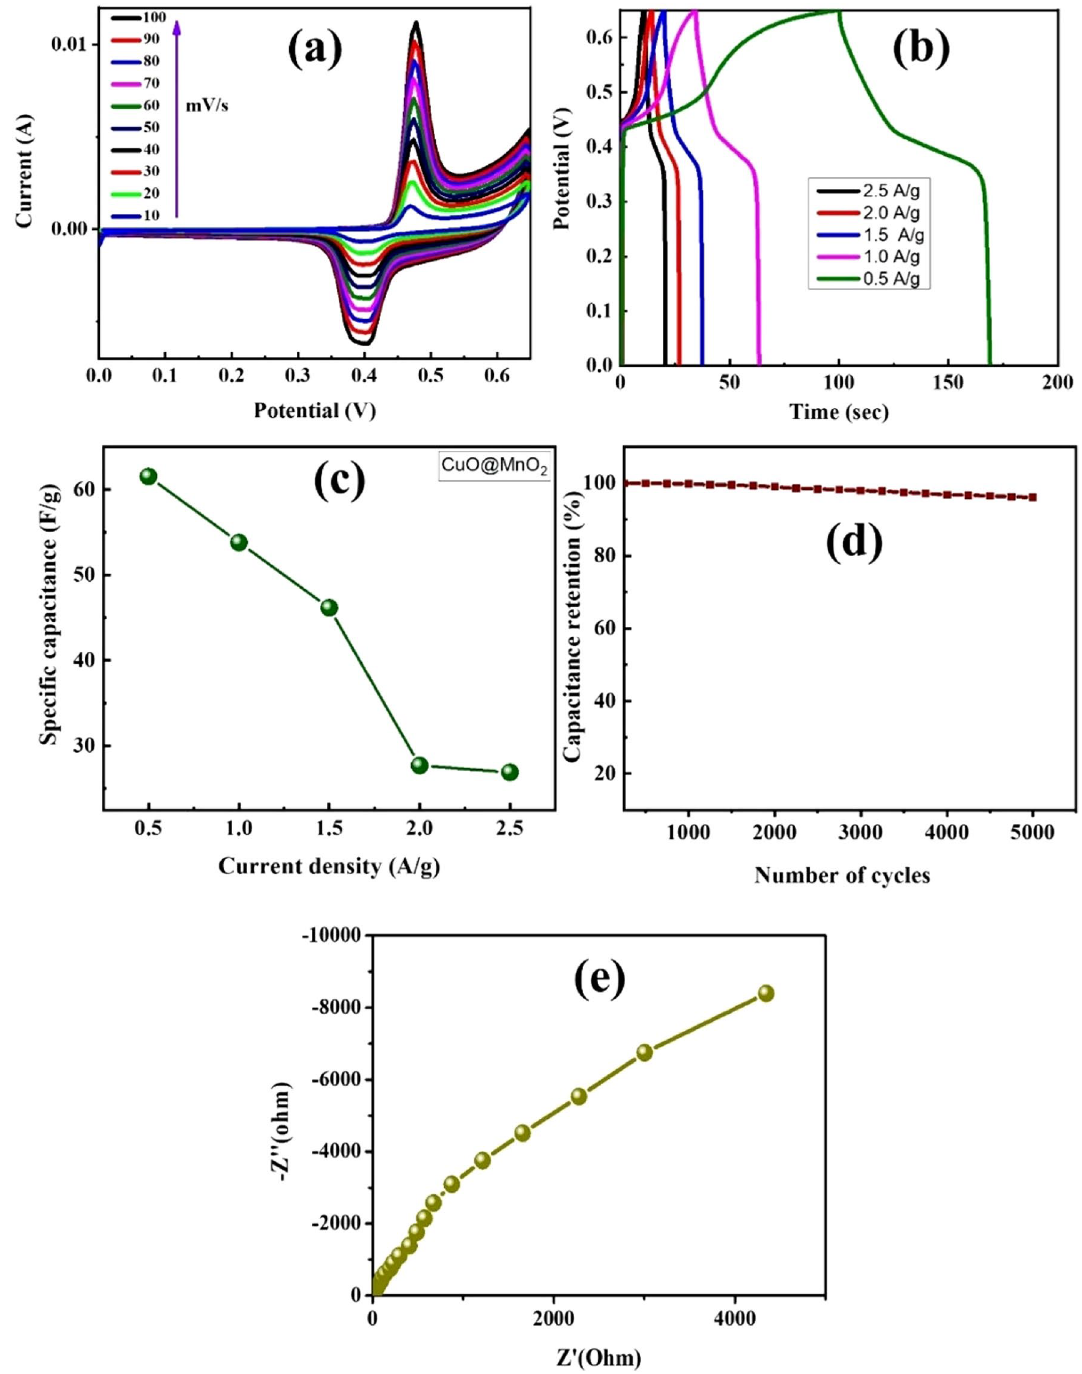
Figure 5. Results of electrochemical CV analysis. ( a ) CV; ( b ) GCD; ( c ) variation of specific capacitance with current density; ( d ) cyclic stability; and ( e ) EIS of the CuO@MnO 2 composite